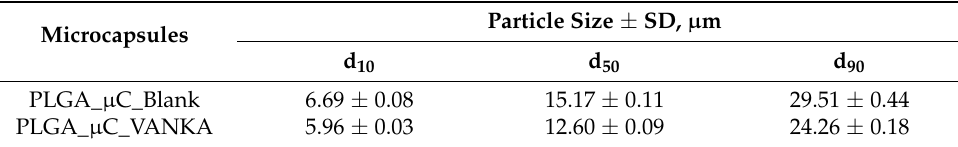
Figure 3. Particle size distribution of blank PLGA microcapsules and VANKA-loaded PLGA microcapsules. Table 3. Particle size distribution of VANKA-loaded PLGA microcapsules prepared via w/o/w